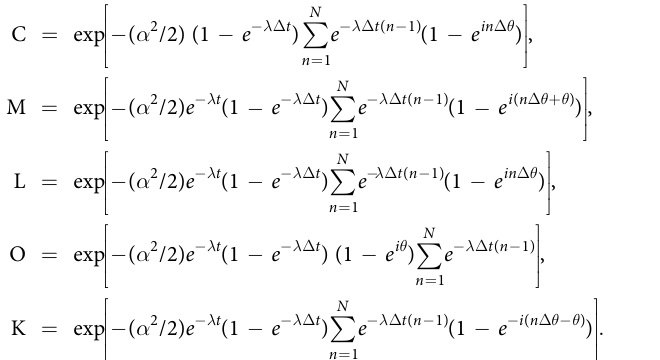
Figure 6 represents the absolute values of coherent parameters (the off-diagonal terms in ρ RR , Eq. 19) with regard to the difference in the amplitudes of the probe beam, α with the fixed αθ = αχ t = 2.5 for P err < 10 − 3 in the optical fiber having a signal loss χ / λ = 0.0303 (0.15 dB/km) 70,71,74,86 .